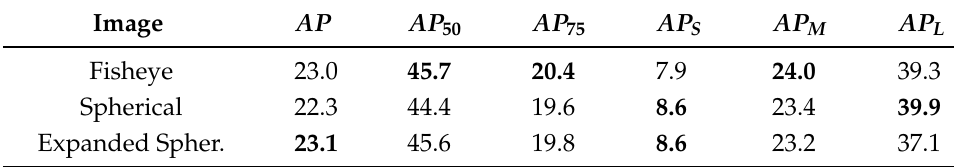
Table 11. Accuracy of different projections of LCat model on the WoodScape.